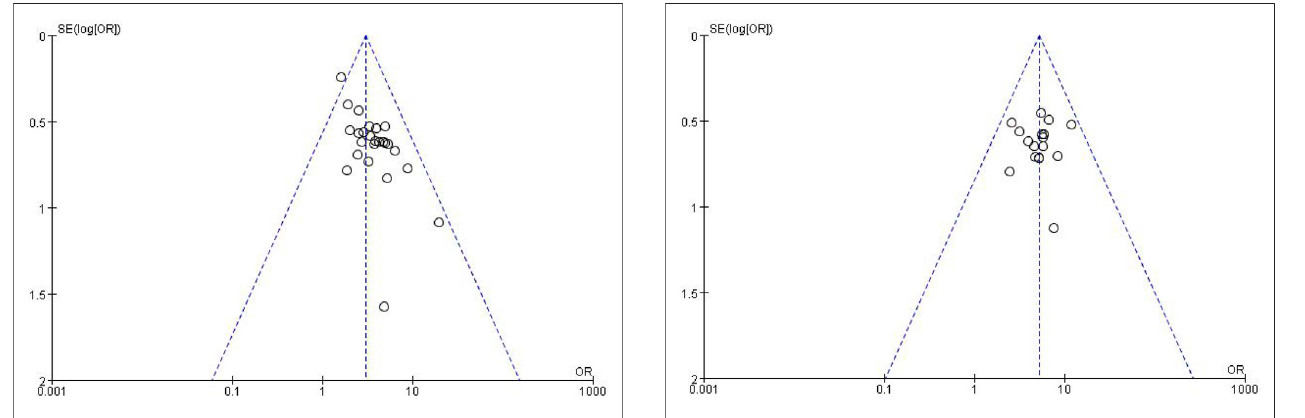
FIGURE 14 | Peripheral neurotoxicity funnel plot. FIGURE 15 | Overall response rate funnel